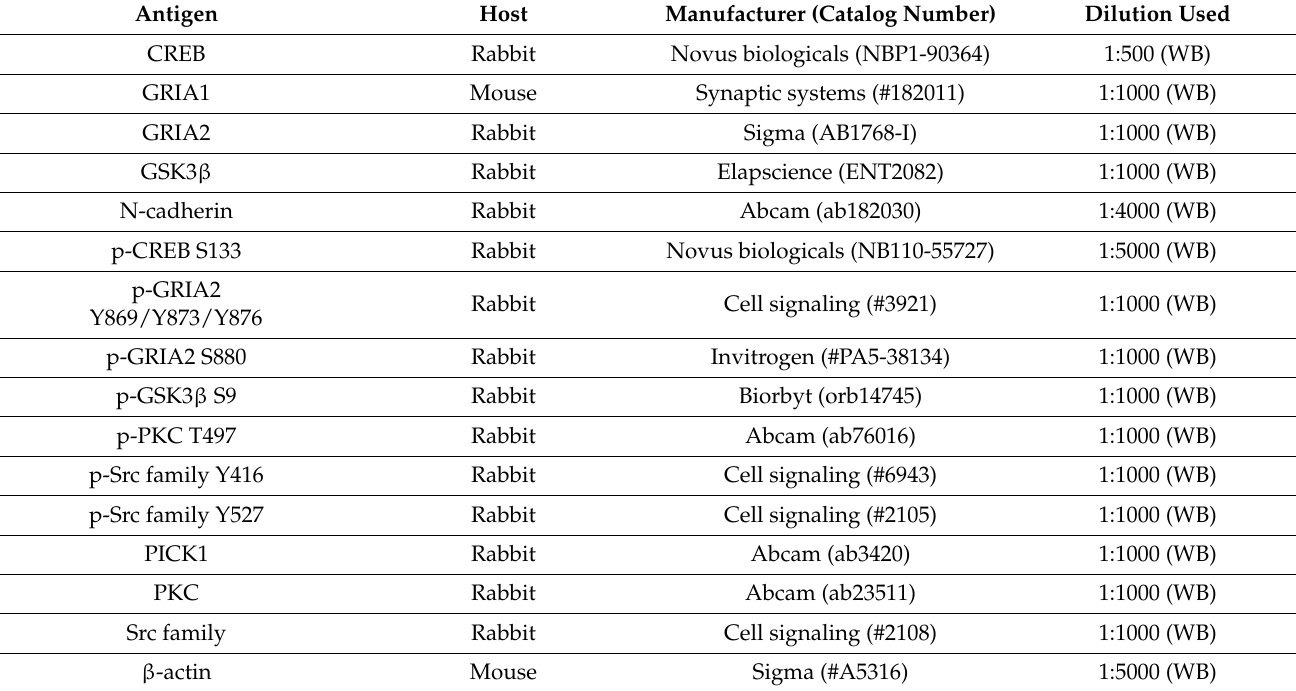
Table 1. Primary antibodies used in the present